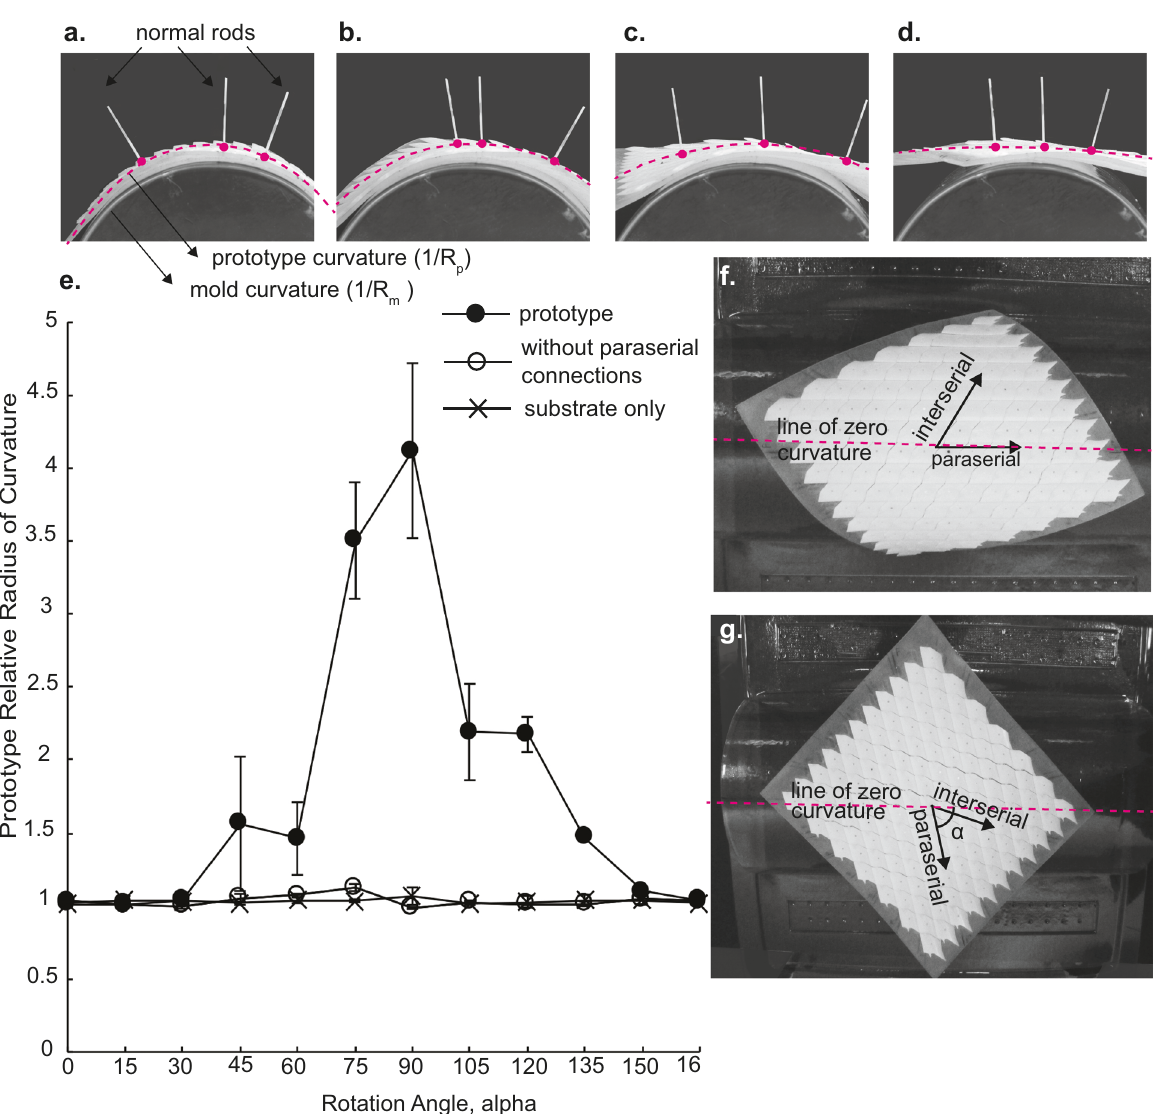
Fig. 3 Anisotropy of prototype fl exibility measured by radius of curvature. a Prototype with an array of 72 scales is draped over a half-cylinder mold at angle ( α ) = 0° between the prototype ’ s paraserial axis and the mold ’ s line of zero curvature. Lines show the curvature of the mold (white) and prototype (red). Inverse of curvature represents the radius of curvature of the prototype ( R p ) and the radius of curvature of the mold ( R m ). The prototype exhibits different curvatures when rotated to b α = 30°, c α = 60°, d α = 90°. e Relative radius of curvature ( R p / R m ) vs. α for the prototype, a variation without the paraserial connections, and the substrate only. Error bars represent standard deviation with N = 3 samples per prototype design. f Top view of the prototype in the α = 0° orientation. g Top view of the prototype in the α = 90°